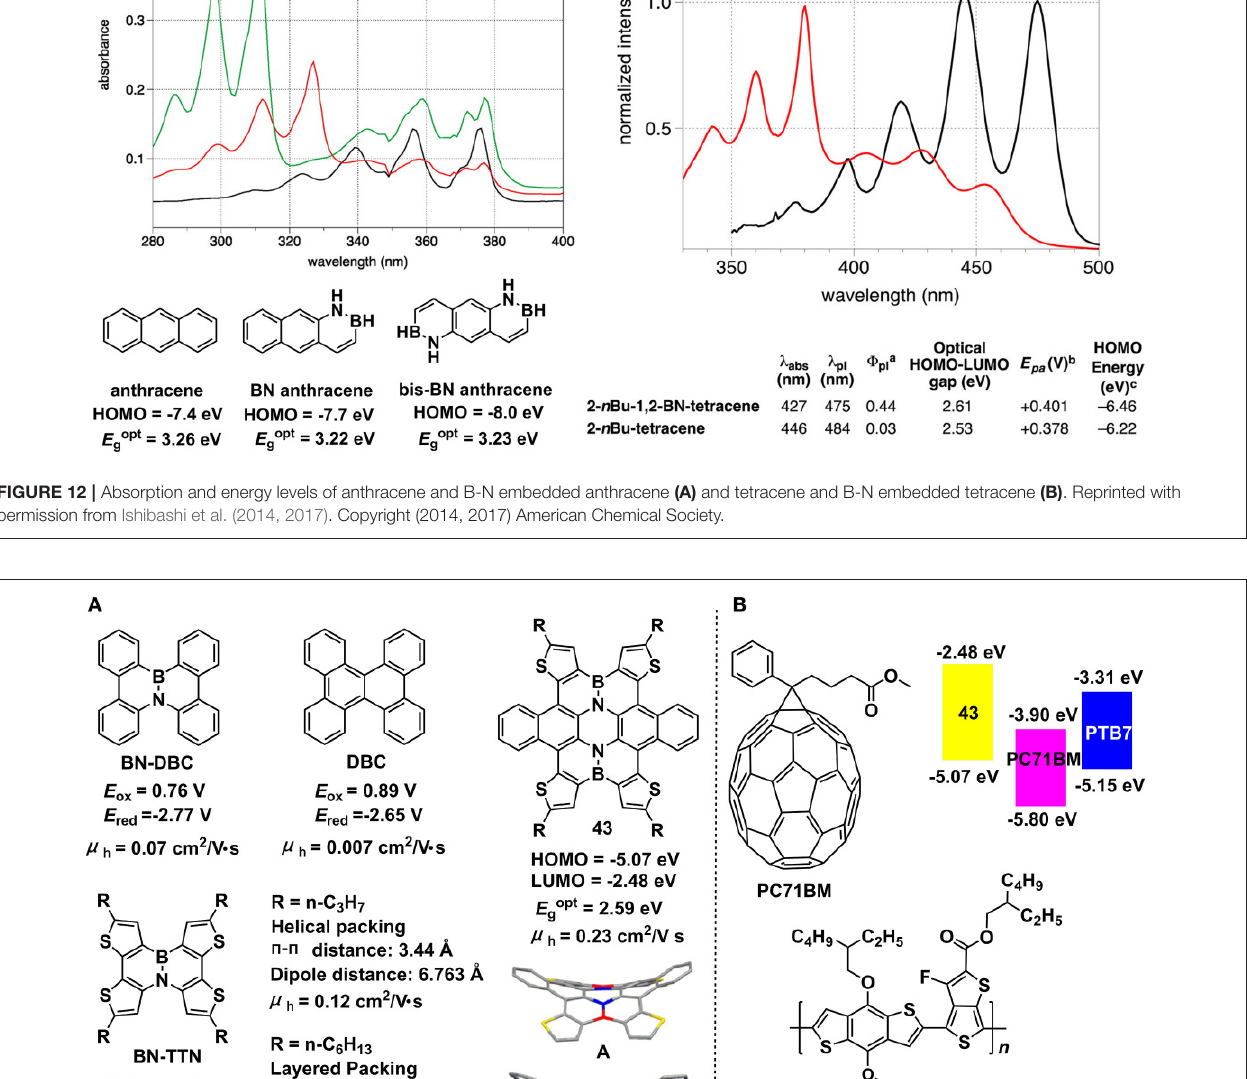
and BN-TTN-C6, respectively. BN-TTN-C3 displayed